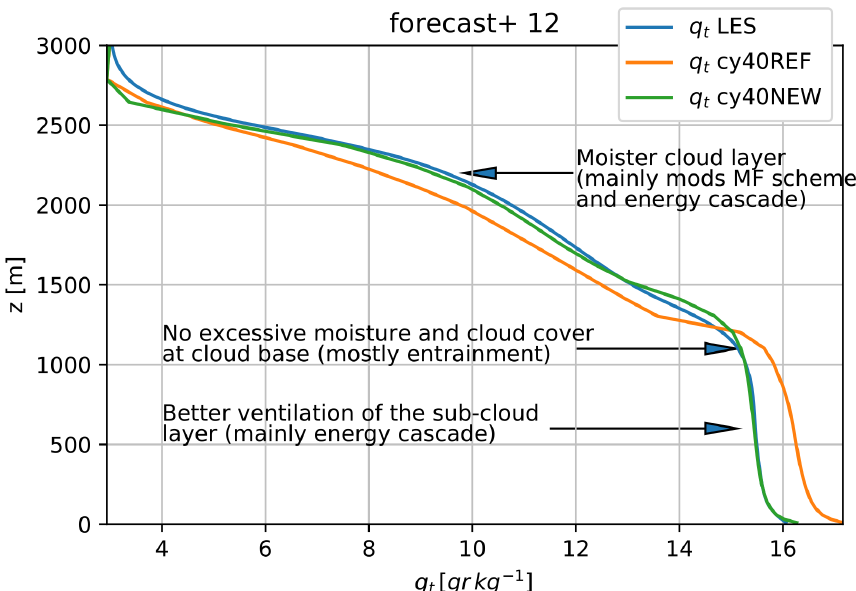
Figure 7. ARM case specific humidity profile after 12h of simulation. These profiles can be seen as the accumulated impact of the total turbulent humidity transport during the ARM